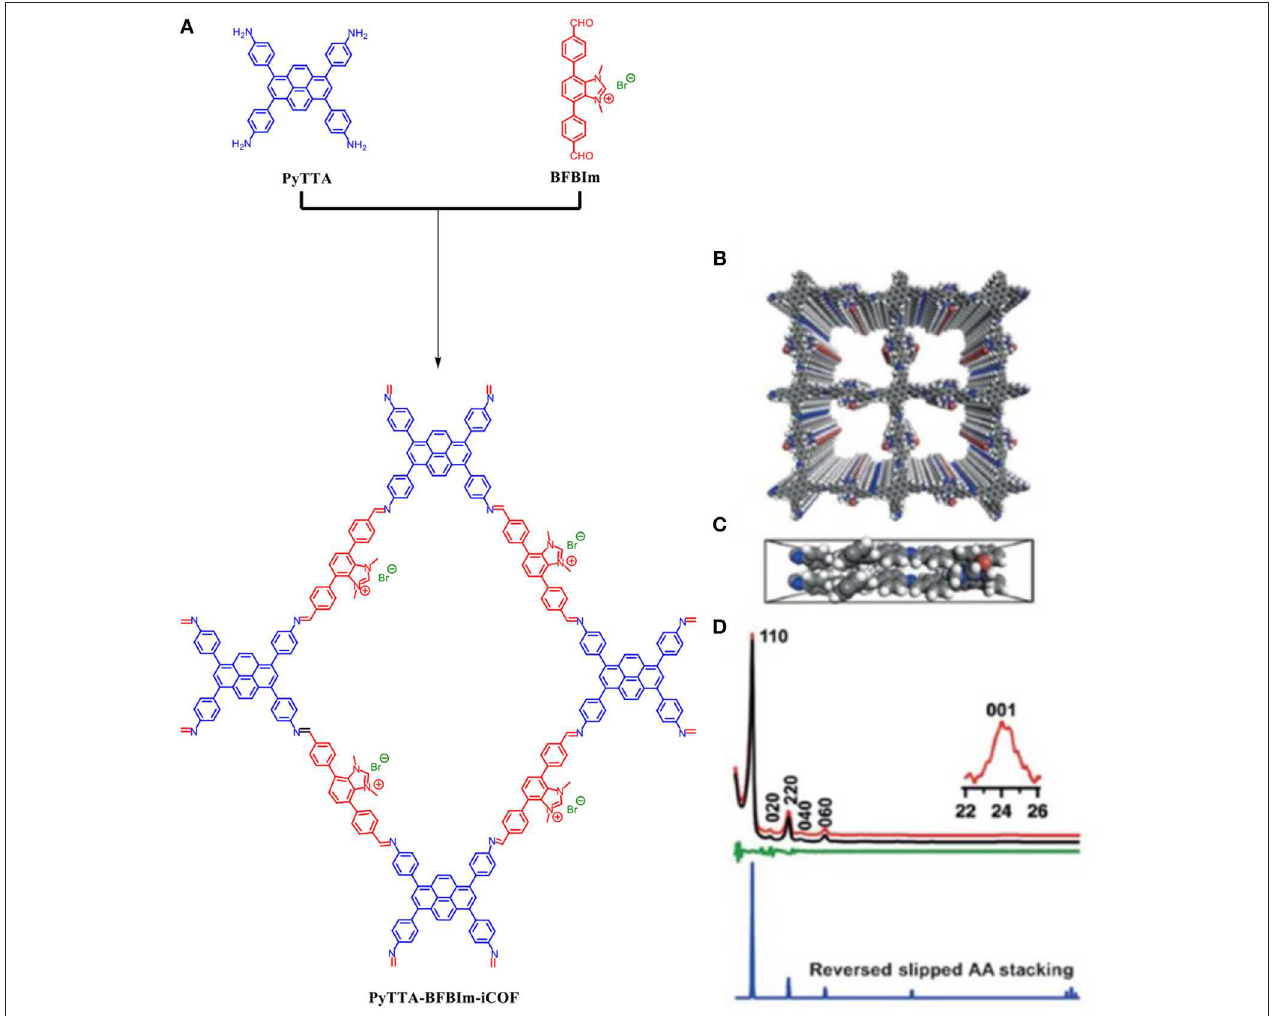
FIGURE 10 | (A) Building blocks and chemical structure of PyTTA-BFBIm-iCOF, (B) Top view of the reversed slipped AA-stacking mode, (C) Bottom view of the reversed slipped AA-stacking mode, and (D) PXRD pattern of PyTTA-BFBIm-iCOF (red) as determined by Huang et al. (2017) Pawley refined pXRD pattern (black), their difference (green) a simulated curve for reversed slipped mode (blue) as determined by Huang et al. (2017) Reprinted with permission © 2017 Wiley VCH.